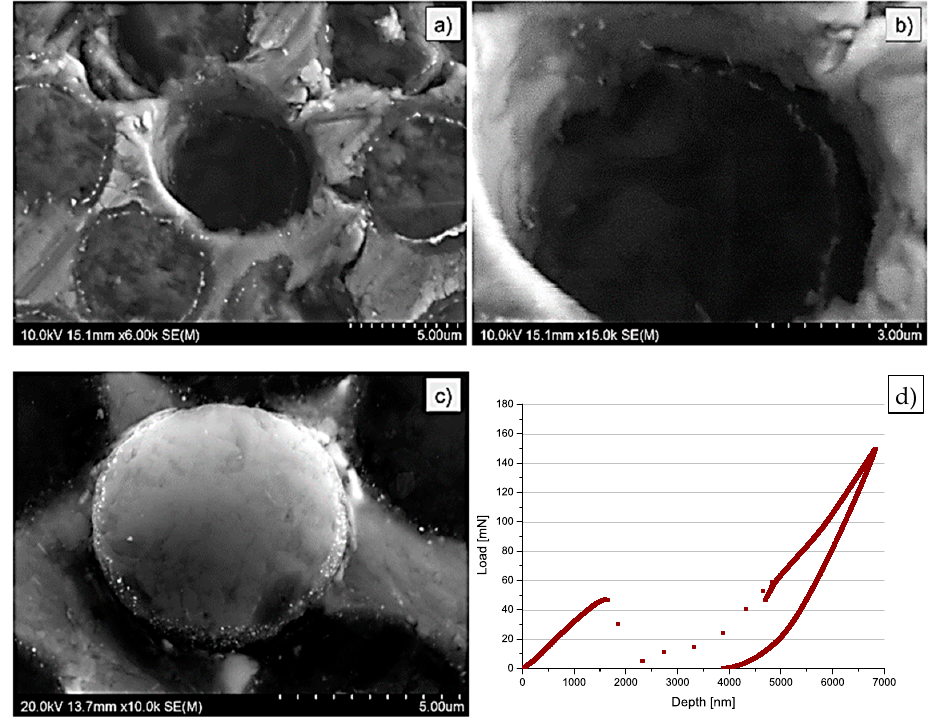
Figure 6. SEM images of the MMC2 sample after push-out tests: ( a,b ) top; ( c ) bottom surface; ( d ) typical curve obtained during push out tests with MMC2 sample.